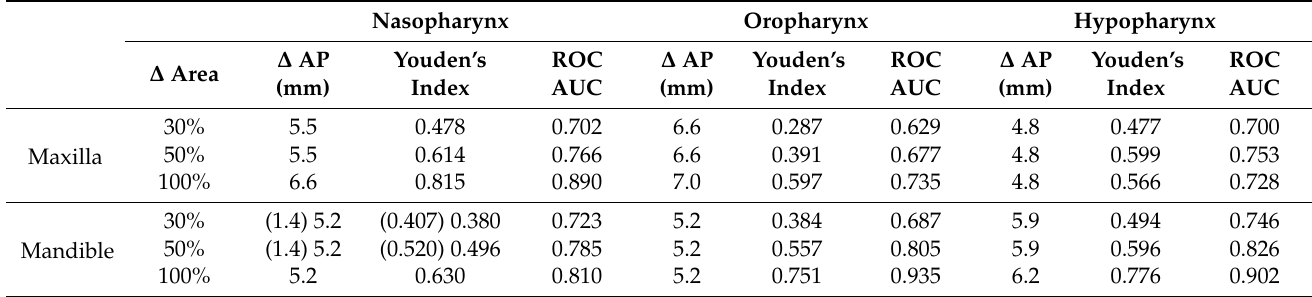
Table 3. Maxillary and mandibular AP displacement ( ∆ AP) threshold points identified by receiver operating characteristic (ROC) curves for each considered ∆ Area increase and subregion. Youden’s indexes corresponding to each threshold point and ROC curve area under curve (ROC AUC) are also reported.